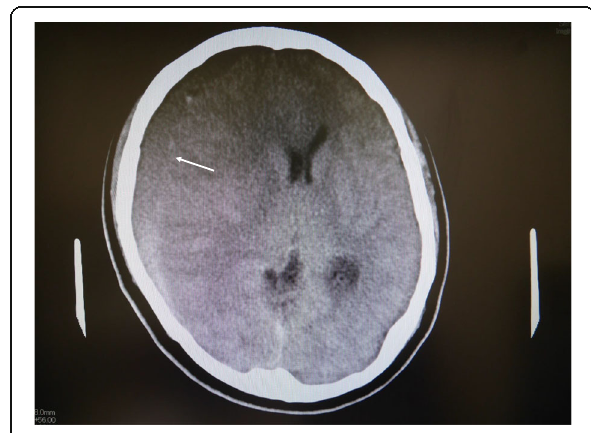
Fig. 1 Computed tomogram obtained at the time of readmission to the emergency room. A subdural hematoma ( arrow ) is seen